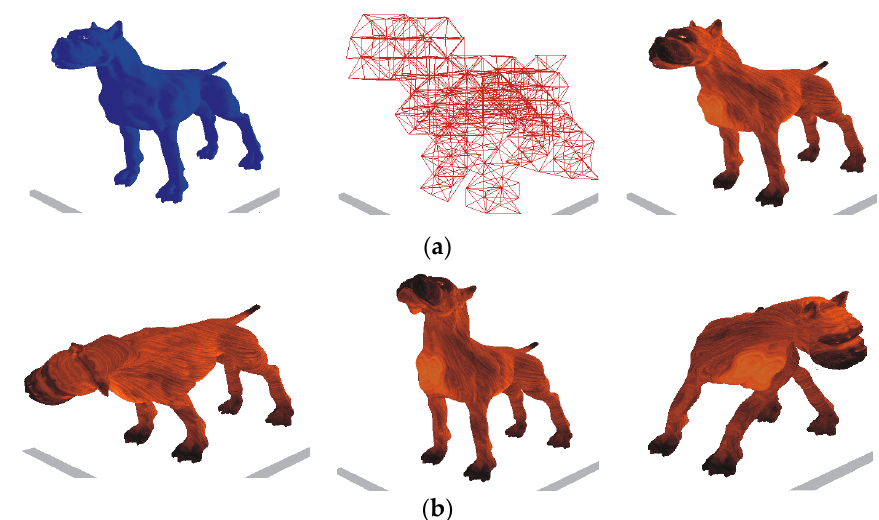
Figure 5. Dog model: ( a ) Geometry, FE mesh, and texture; ( b ) screenshots from an interactive